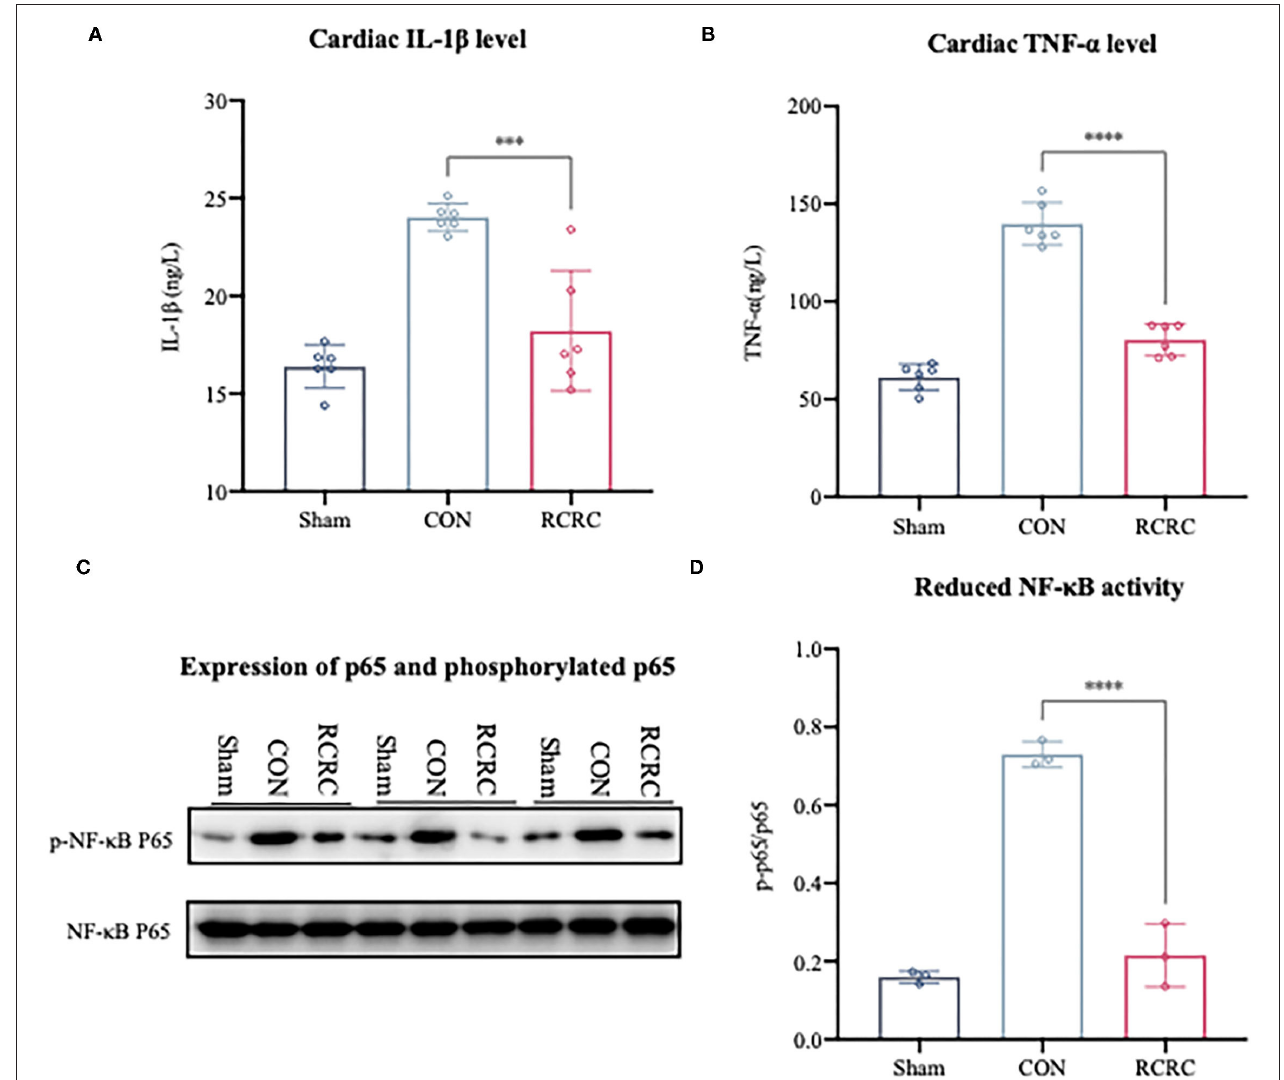
FIGURE 2 | Remote conditioning by rhythmic compression abates the inflammatory response in the hearts of AMI rats. (A,B) The concentrations of IL-1 β and TNF- α in the heart were determined by ELISA, N = 6. (C,D) The levels of phosphorylated p65 (p-p65) and total p65 in heart were detected by western blot. The corresponding quantification data of p-p65 to p65 ratio are shown in right panel. All values represent as means ± SD. N = 3. *** p < 0.001, **** p < 0.0001 vs.